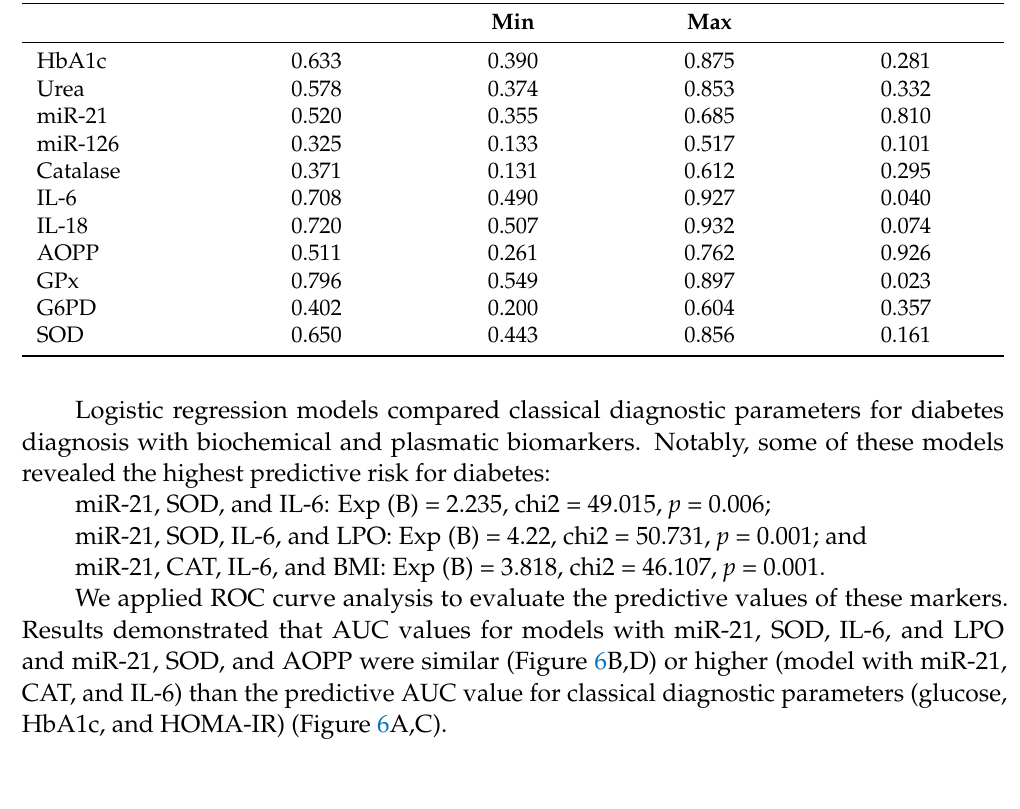
Table 6. AUC and 95% confidence intervals for studied markers distinguishing between T2DM NC and T2DM + C.